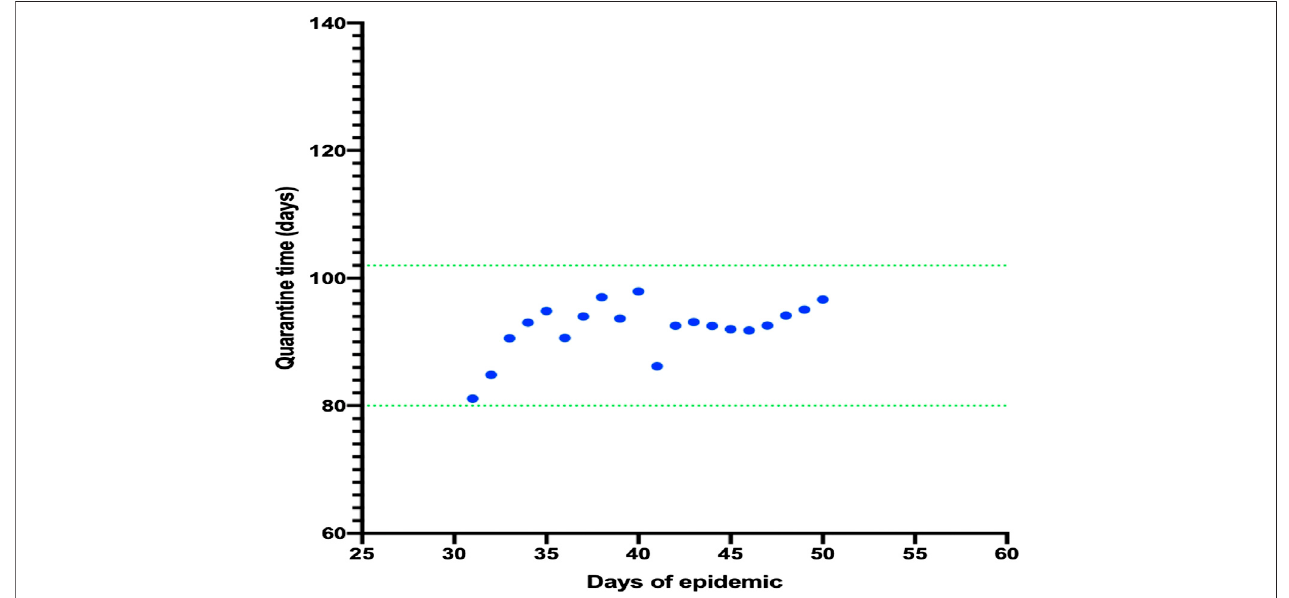
FIGURE 4 | Fso and herd-immunity values with R 0 for each model. An increase in R 0 for each SIR model led to an increase in the infected population and herd immunization, but neither of these values reached 100% of the population.